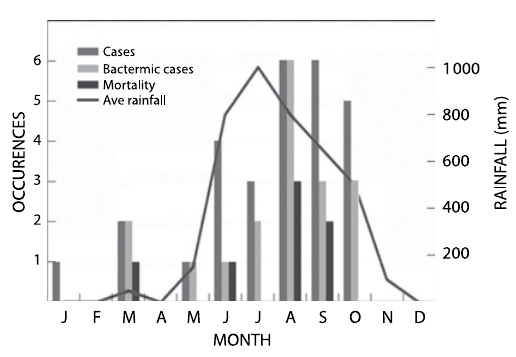
Figure 2: Relationship between average monthly rainfall, occurrence of cases, bacteraemia and deaths.